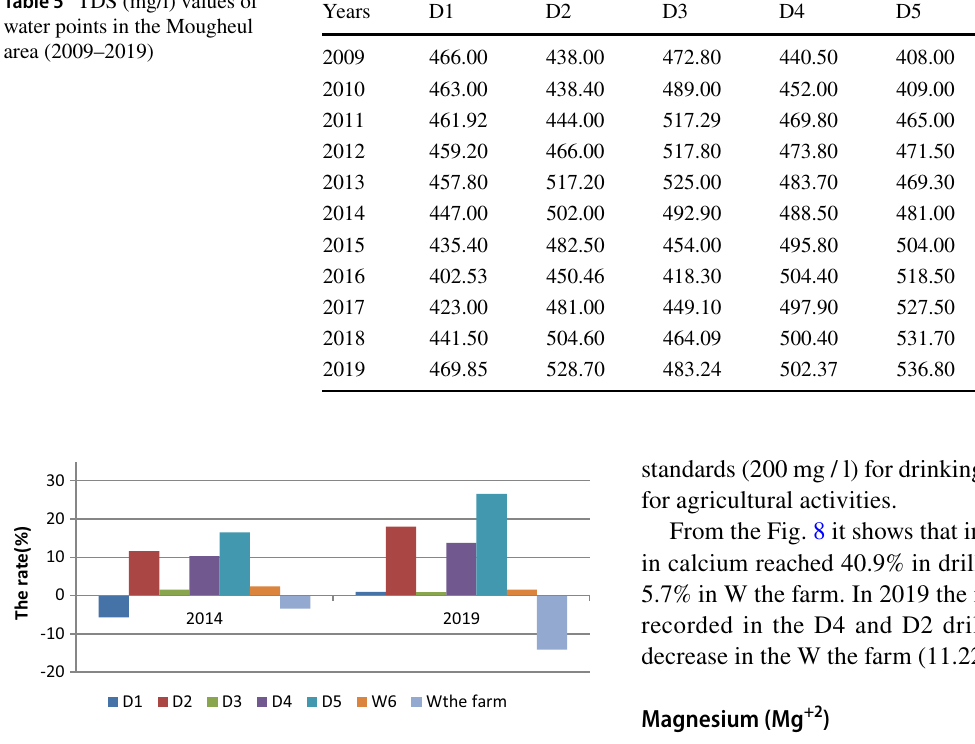
Fig. 7 The rate of change in TDS between 2014 and 2019